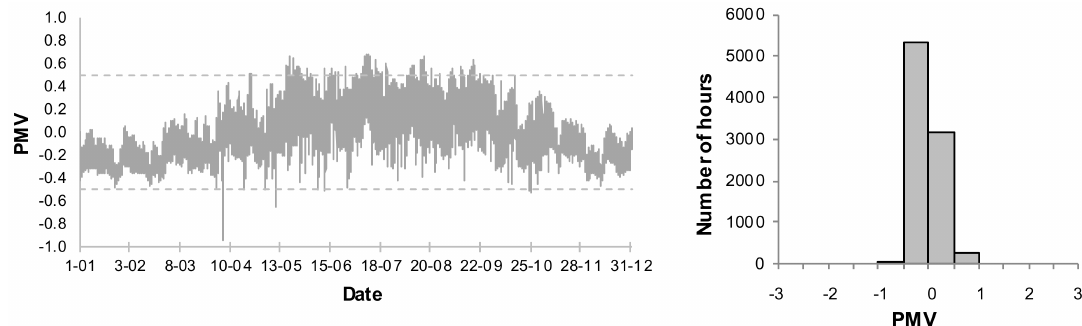
Figure 15. Annual variation and frequency distribution of Predicited Mean Vote (PMV) for living room in case